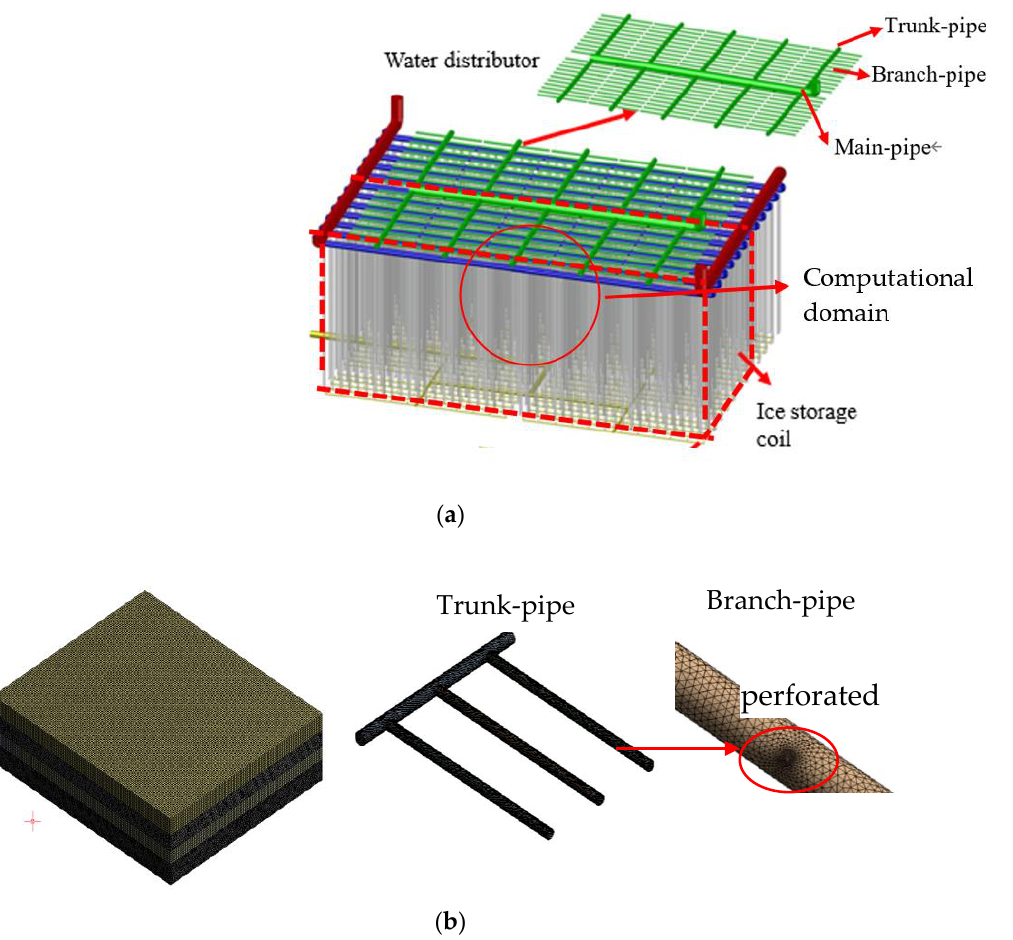
Figure 1. ( a ) Schematic diagram and computational domain of the external ice melting device with a water diffuser and ( b ) the generated grid.